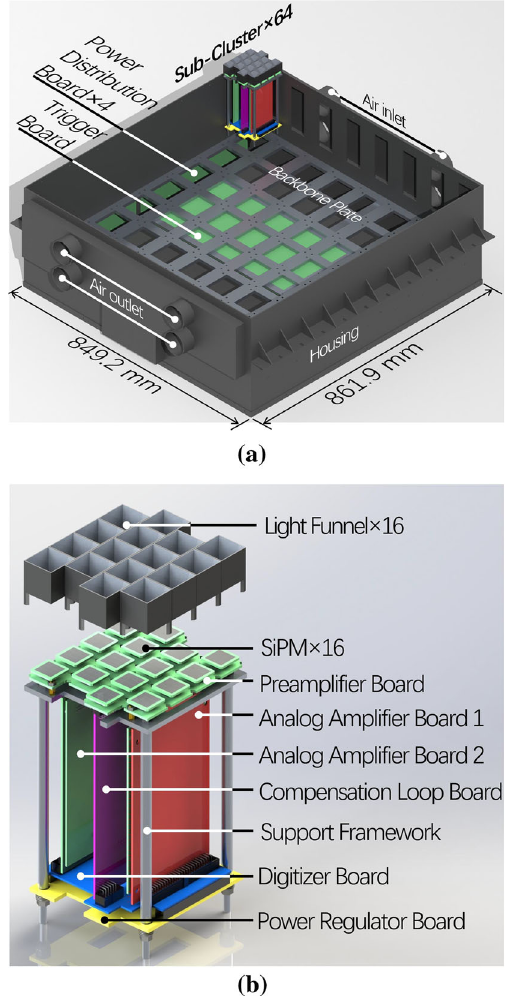
Fig. 2 The structure of the WFCTA SiPM camera ( a ) and its sub- cluster ( b